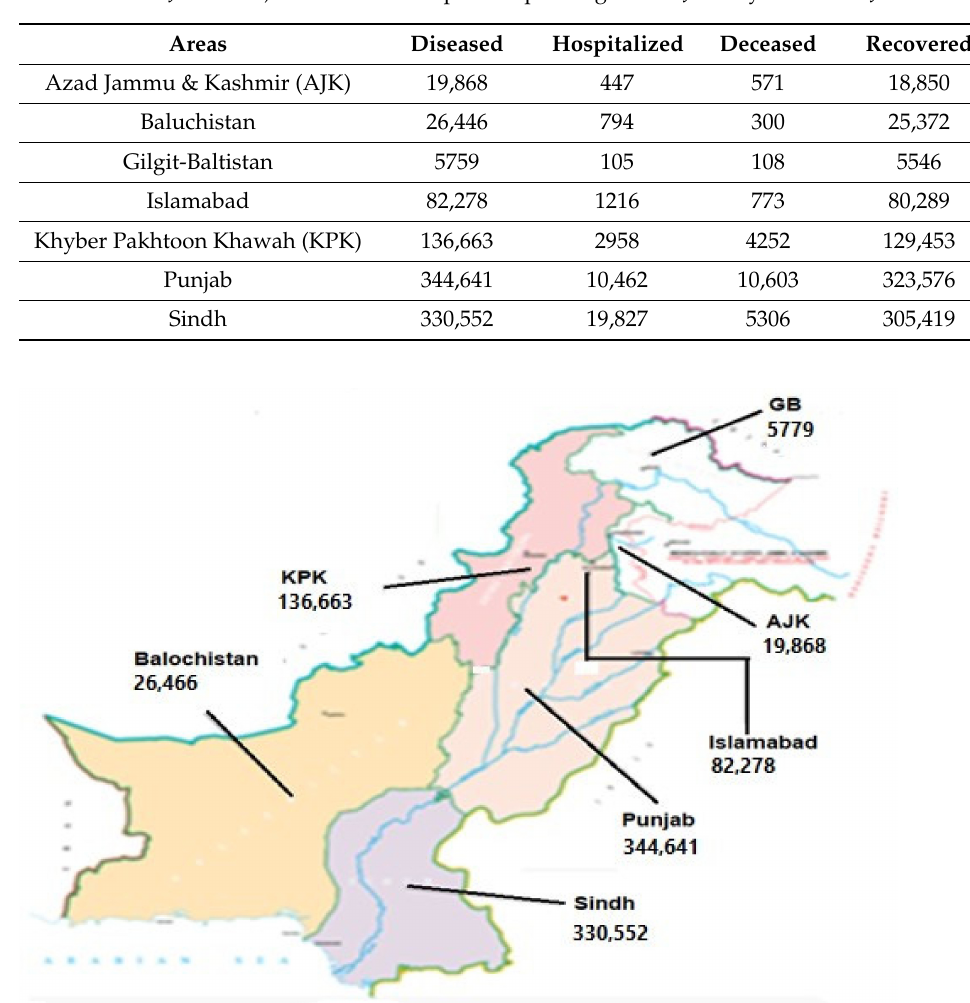
Figure 1. Number of the total cases of COVID-19 in different provinces/territories of Pakistan up to 16 June 2021. COVID-19 cases of Islamabad, Capital of Pakistan, are also shown here. This map is adopted from https://covid.gov.pk/ accessed on 16 June